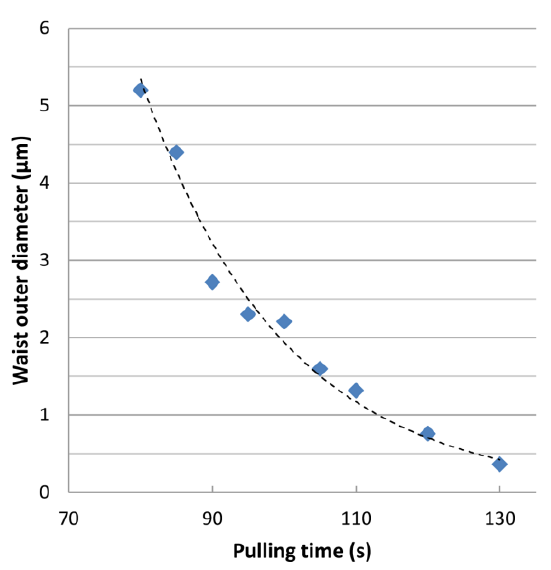
Fig. 3. Waist outer diameter of the fabricated tapered capillaries as a function of the pulling time (pulling speed: 340